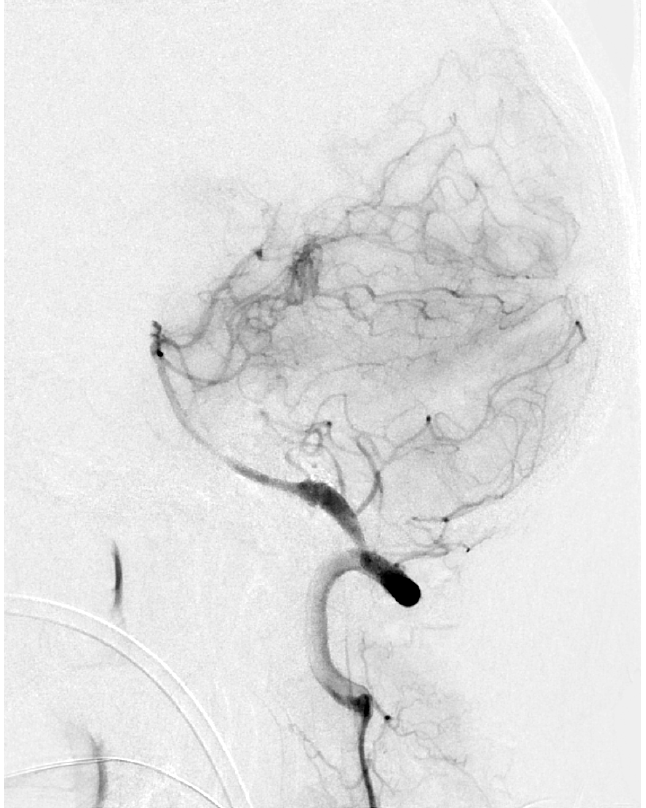
Figure 5. Lateral view of basilar artery catheter angiogram in a patient with recent subarachnoid hemorrhage demonstrating mid-basilar artery vasospasm.